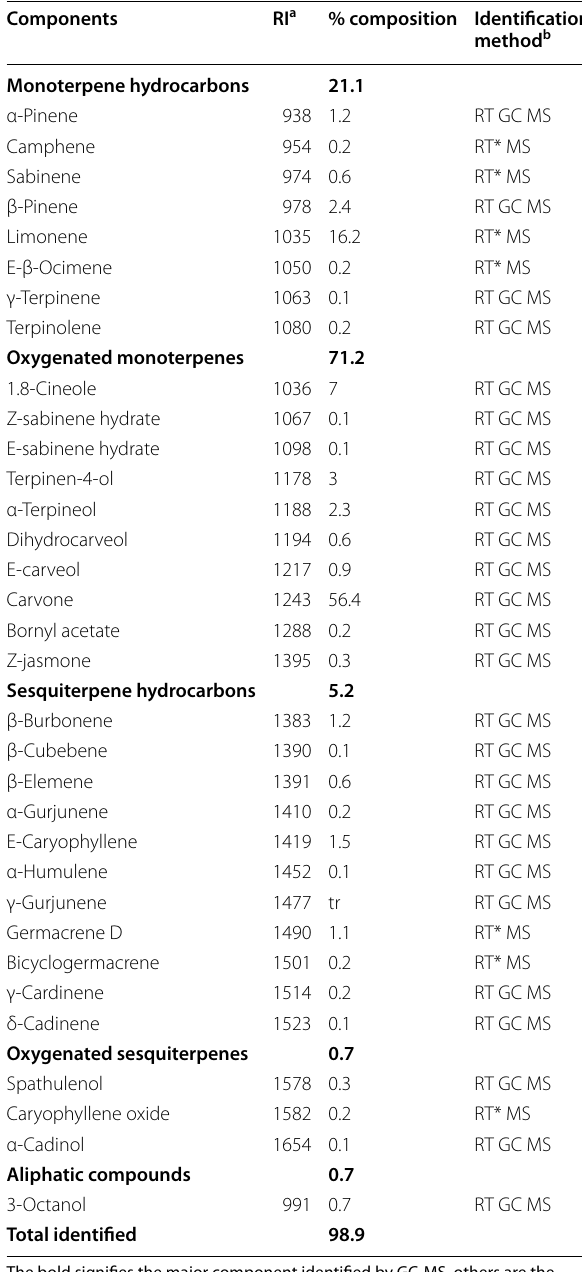
Table 7 Chemical composition of Mentha spicata L. essential